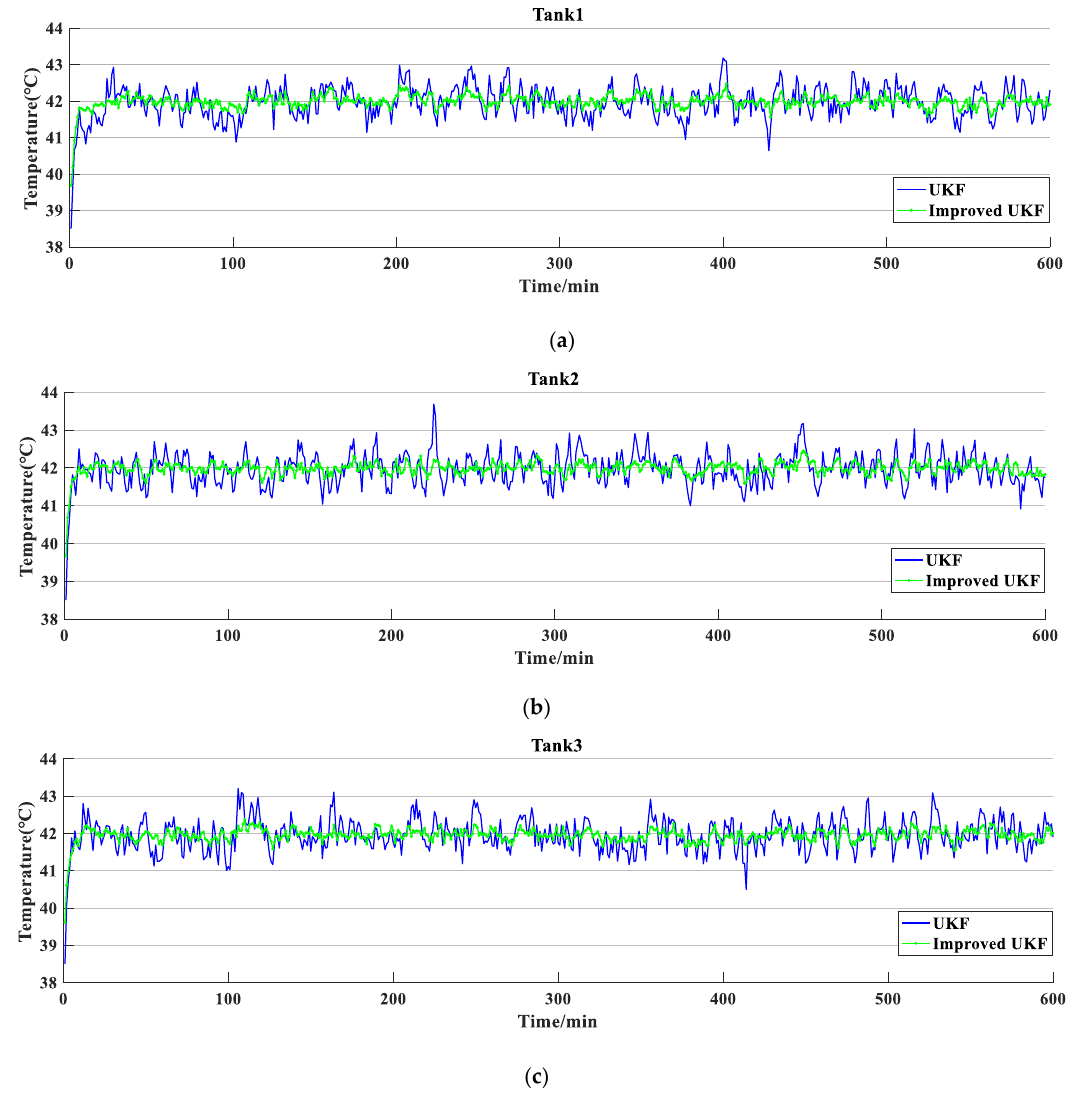
Figure 10. Comparison of simulation results between traditional and improved unscented Kalman filter (UKF) in ( a ) Tank1, ( b ) Tank2, and ( c ) Tank3.